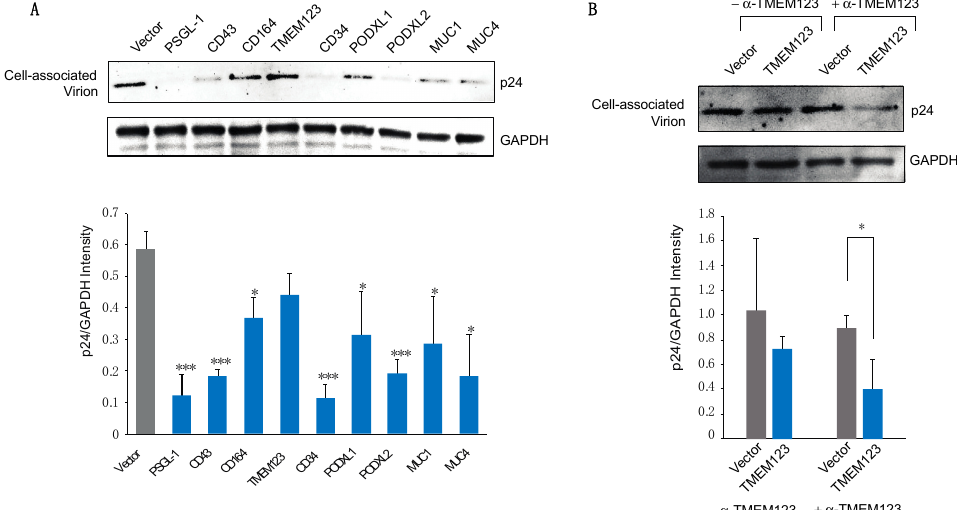
Figure 5. SHREK proteins block HIV-1 virion attachment to target cells. ( A ) Viral particles were produced by cotransfection of HEK293T cells with pHIV-1(NL4-3) DNA (1 µg) and each individual SHREK protein expression vector or an empty vector (500 ng). HIV-1 p24-normalized viral particles were then assayed for attachment to target HeLaJC.53 cells by Western blot for cell-bound p24. ( B ) Virions produced in the presence of the TMEM123 expression vector or the empty vector were assayed for attachment in the presence or absence of an anti-TMEM123 antibody. Representative blots from 3 experiment repeats are shown. The band intensities were quantified (for A and B ) from the three blots and normalized with GAPDH. p -values were calculated using the two-tailed T-test. Significance values are indicated using asterisks as follows; * = p < 0.05, *** = p < 0.001.